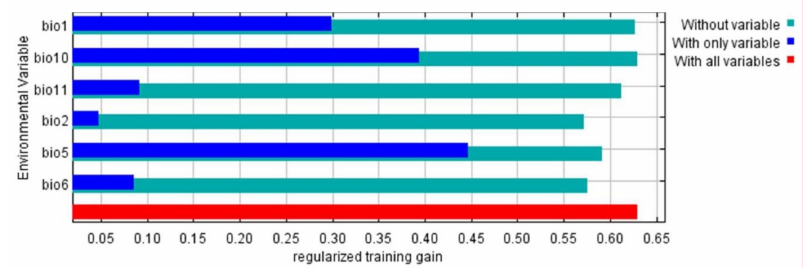
Figure 6. The jackknife test of the most important